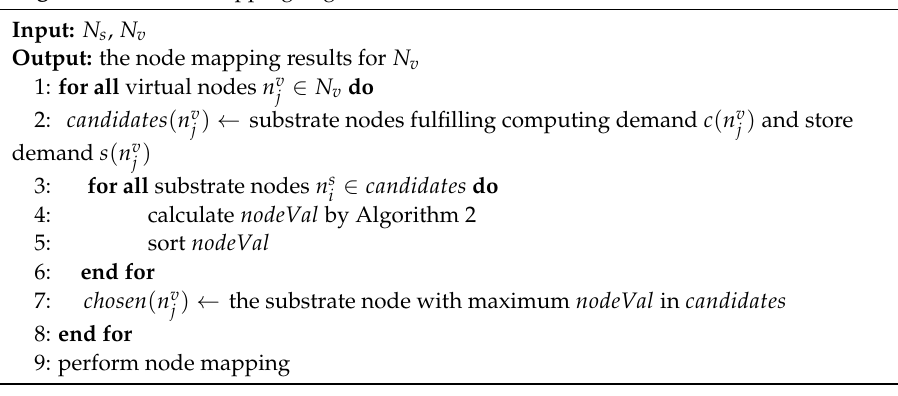
Algorithm 1 Node Mapping Algorithm.